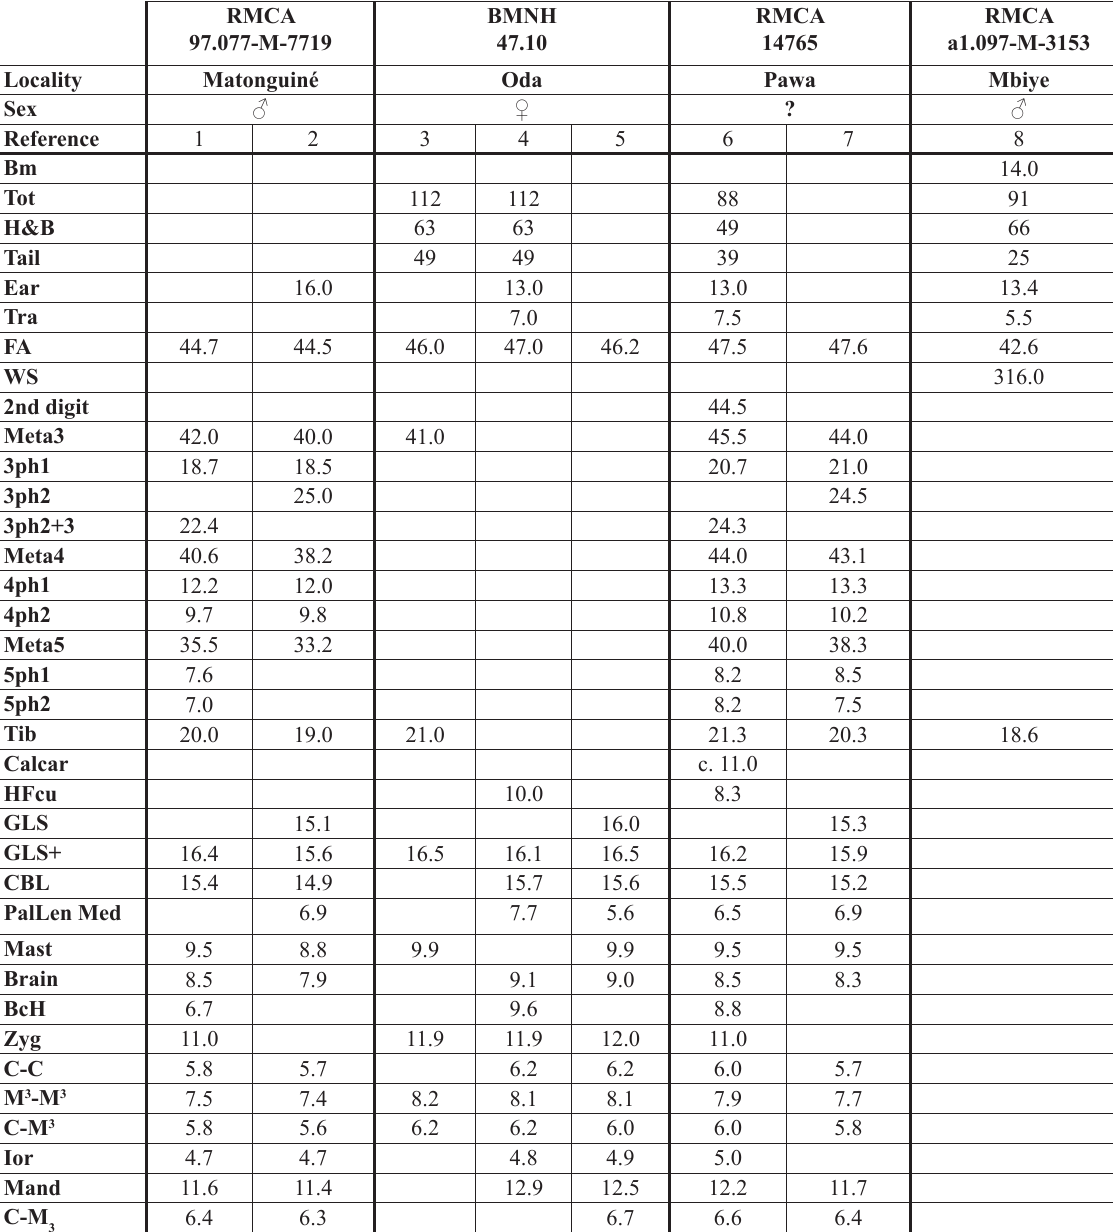
Table 1. Craniodental and external measurements of Glauconycteris superba Hayman, 1939. Reference: 1. Randolph L. Peterson (courtesy of Judith Eger, pers. comm. 1 Nov. 2001; column 1). 2, 5, 7. FDV. 3. Rosevear (1965). 4. Hayman (1947). 6. Hayman (1939). 8. GCGT (field measurements). For measurement descriptions see